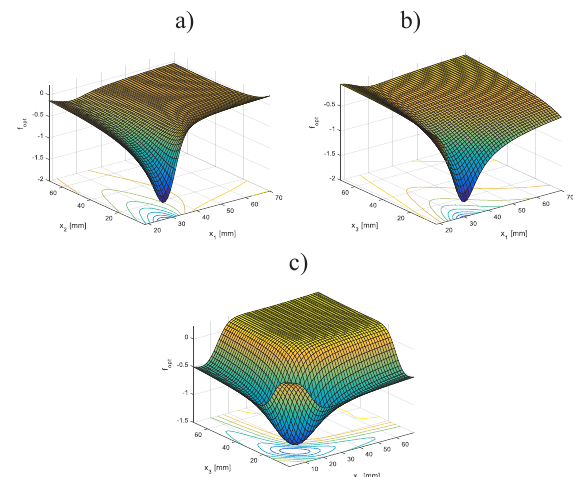
Fig. 3. Variations of flux linkage derivative for initial and optimal